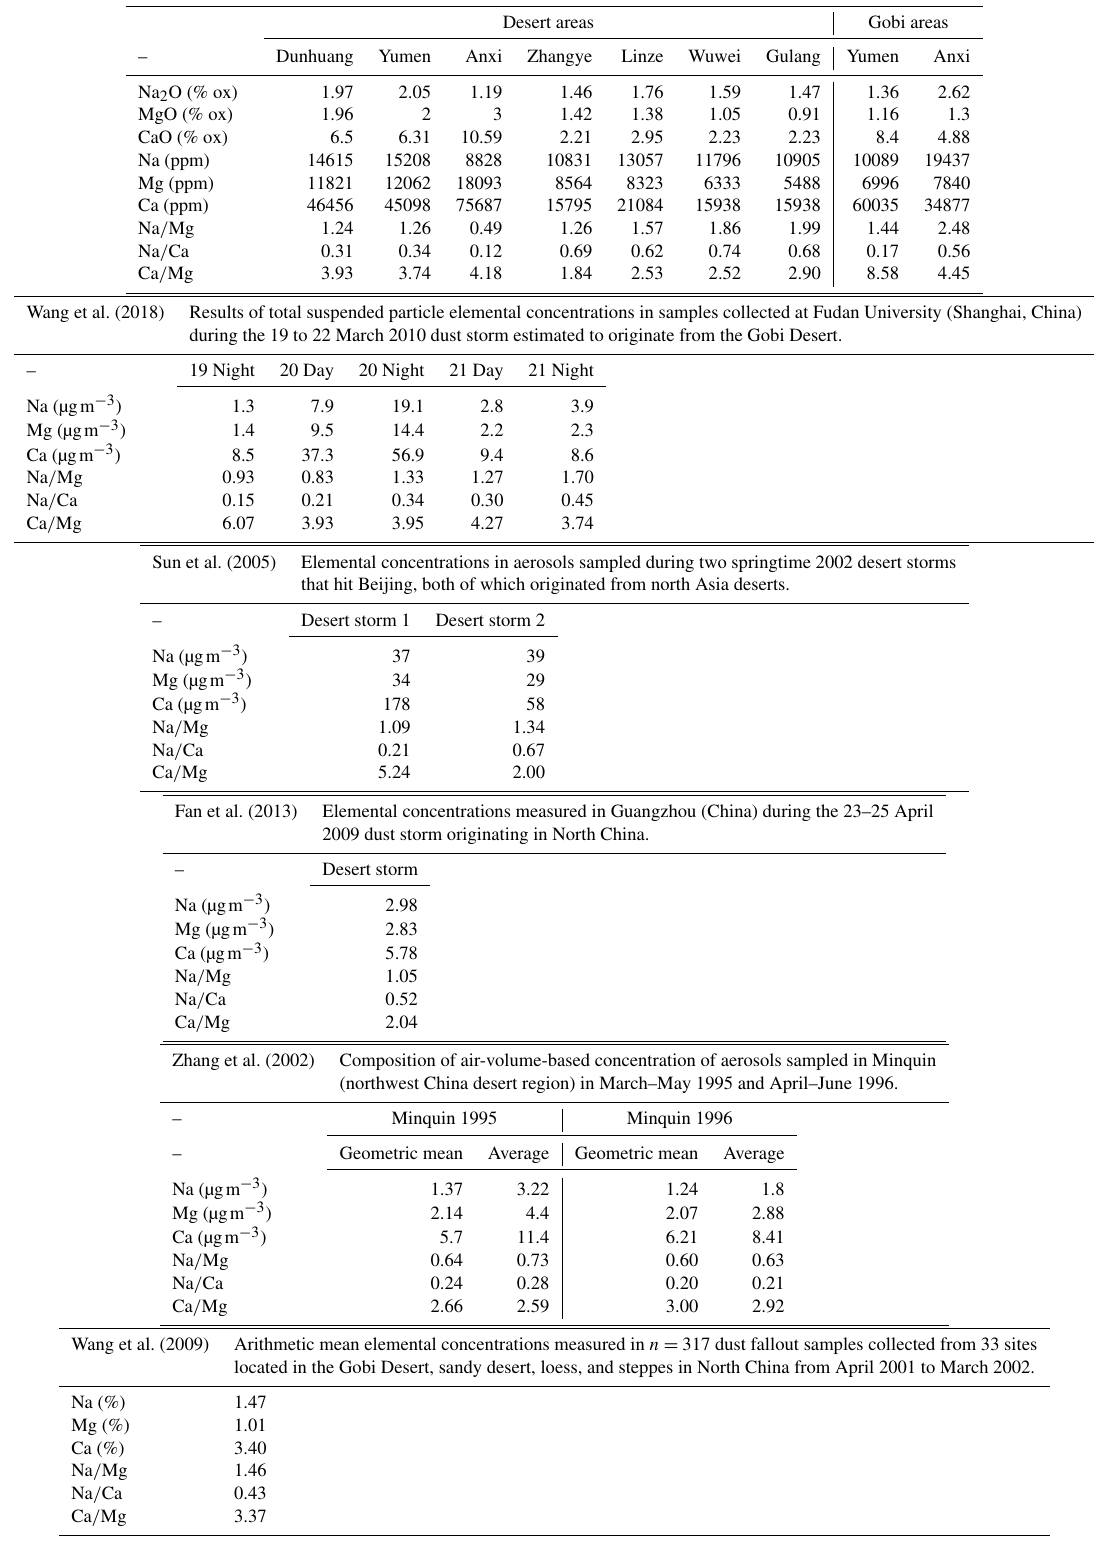
Table A1. Compilation Na / Mg, Na / Ca and Ca / Mg mass ratios in dust samples originating from north Asia deserts. Ta et al. (2003) Results of the X-ray fluorescence analysis of soil samples from the desert/Gobi areas in Gansu province,